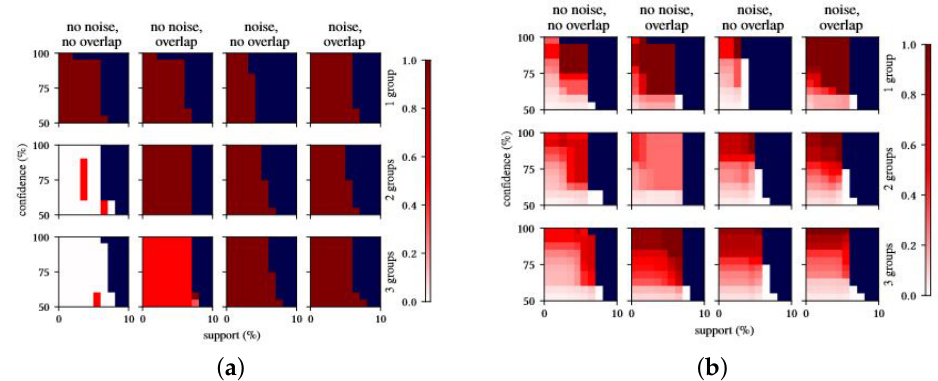
Figure 3. Density results for the synthetic dataset. ( a ) density results for models in the synthetic dataset; and ( b ) density results for rules in the synthetic